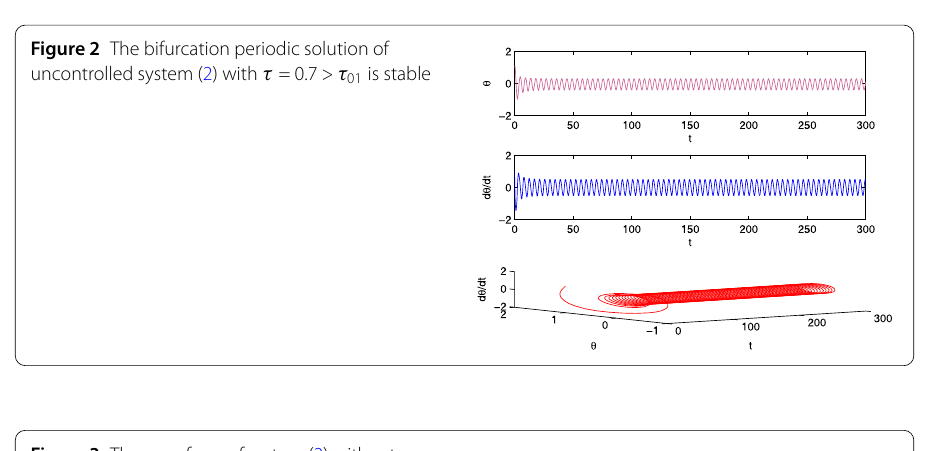
Figure 3 The waveform of system (2) without control at τ = 2.3,2.7,3.1,